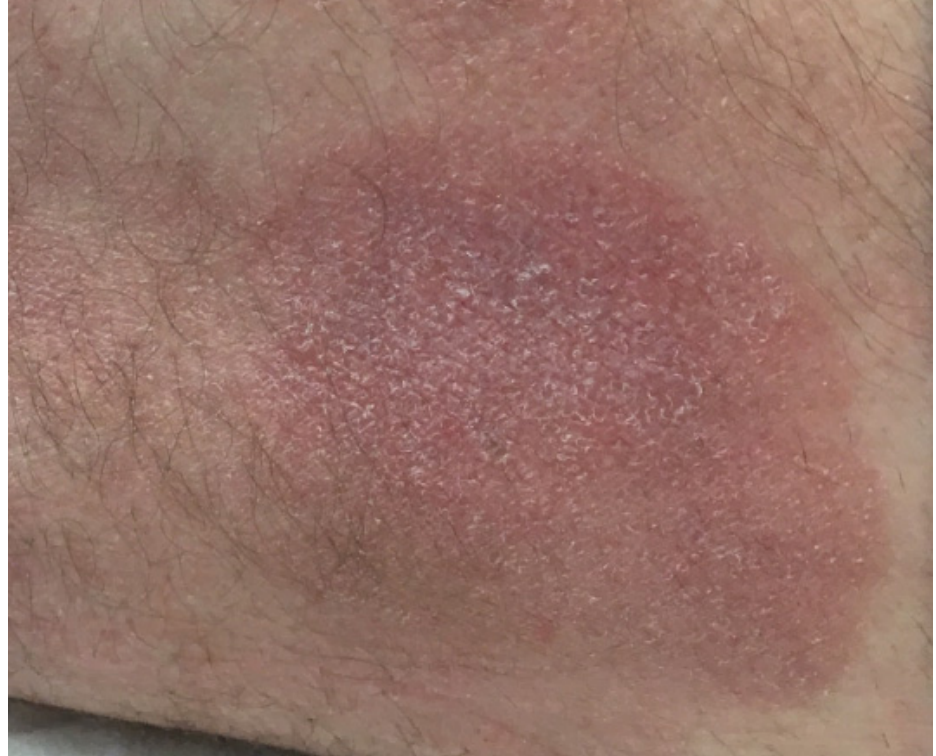
Figure 1. Mycosis fungoides presenting as a scaly, erythematous patch in a Caucasian patient.